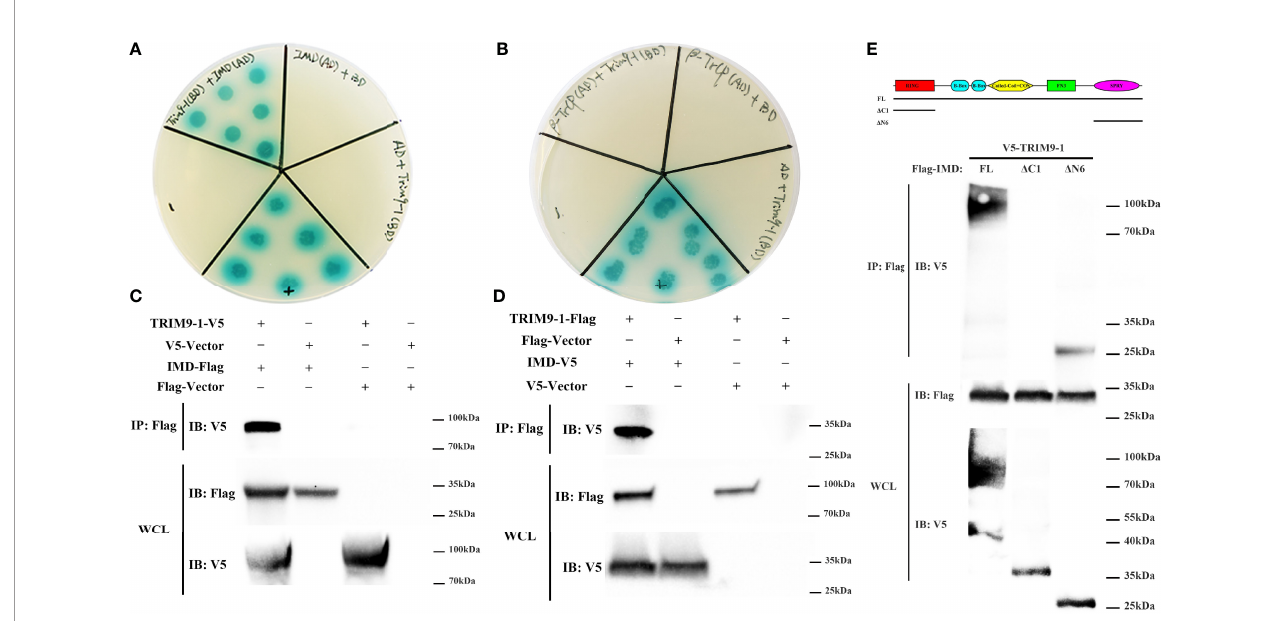
FIGURE 4 | LvTRIM9-1 interacted with LvIMD through its SPRY domain. (A, B) Determination of the interaction between LvTRIM9-1 and LvIMD or Lv b -TrCP by a Y2H assay. Y2H assay results showed that LvTRIM9-1 directly interacts with LvIMD but not with Lv b -TrCP. The colonies were cultured on QDO/X/A plates (-Ade/- His/-Leu/-Trp quadruple dropout media with X-a-Gal and aureobasidin A). pGADT7-T and pGBKT7-p53 were used for the positive control (+); pGADT7-T and pGBKT7-Lam were used for the negative control (-). IMD(AD)+BD, b -TrCP(AD)+BD, and AD+TRIM9-1(BD) were used for the auto-activation detection. IMD(AD), pGADT7-LvIMD; b -TrCP(AD), pGADT7-Lv b -TrCP; TRIM9-1(BD), pGBKT7-LvTRIM9-1; AD, pGADT7 vector; BD, pGBKT7 vector. (C, D) Determination of the interaction between LvTRIM9-1 and LvIMD by a Co-IP assay. Co-IP results showed that LvTRIM9-1 directly interacts with LvIMD. (C) Anti-V5 Western blot bands show the expression of LvTRIM9-1-V5, and anti-Flag Western blot bands show the expression of LvIMD-Flag. (D) Anti-Flag Western blot bands show the expression of LvTRIM9-1-Flag, and anti-V5 Western blot bands show the expression of LvIMD-V5. (E) Determination of the key region of LvTRIM9-1 involved in LvTRIM9-1 and LvIMD interaction by a Co-IP assay. The sites for mutation of LvTRIM9-1 are also labeled under the